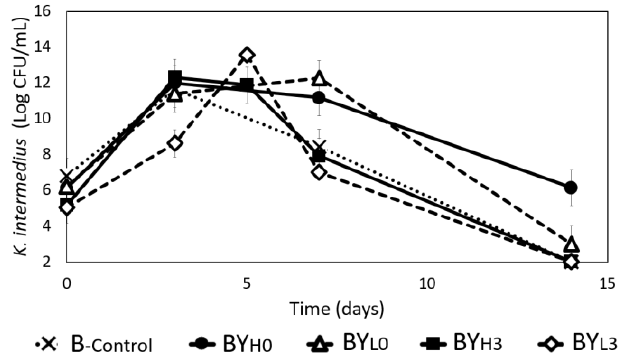
Figure 1. K. intermedius growth during 14 days of cultivation in mono (B -control ) and co-cultures with D. bruxellensis at 30 ◦ C. D. bruxellensis was added simultaneously at concentrations of 10 6 CFU/mL (BY H0 ) and 10 3 CFU/mL (BY L0 ) and sequentially at 10 6 CFU/mL (BY H3 ) and 10 3 CFU/mL (BY L3 ). D. bruxellensis population in yeast mono (Y -control ) and co-cultures was also monitored.